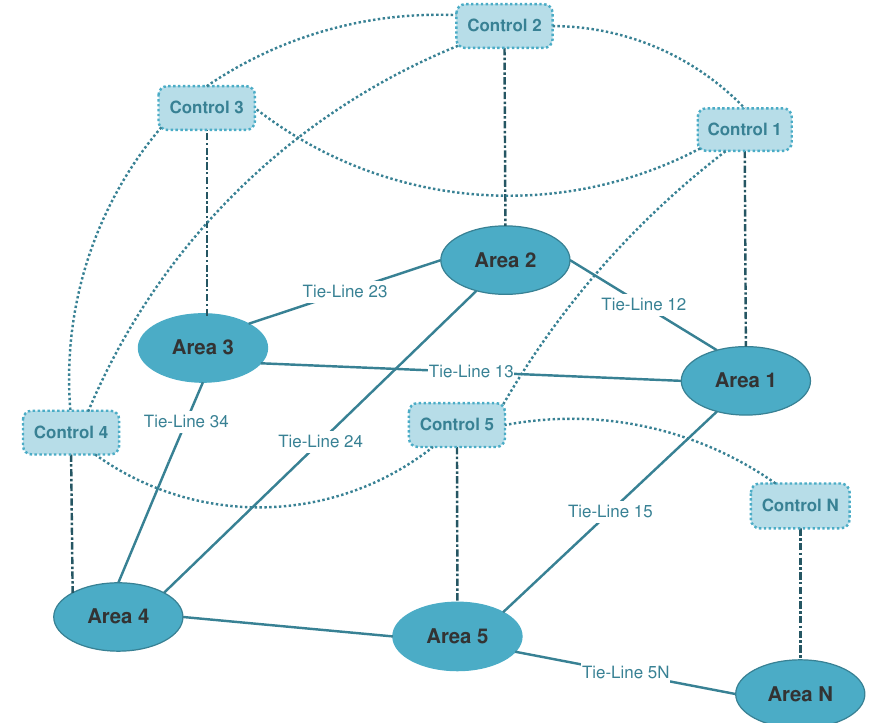
Figure 1. Tie-line interconnections (solid lines) and communication scheme (dotted lines) in large-scale multi-area power